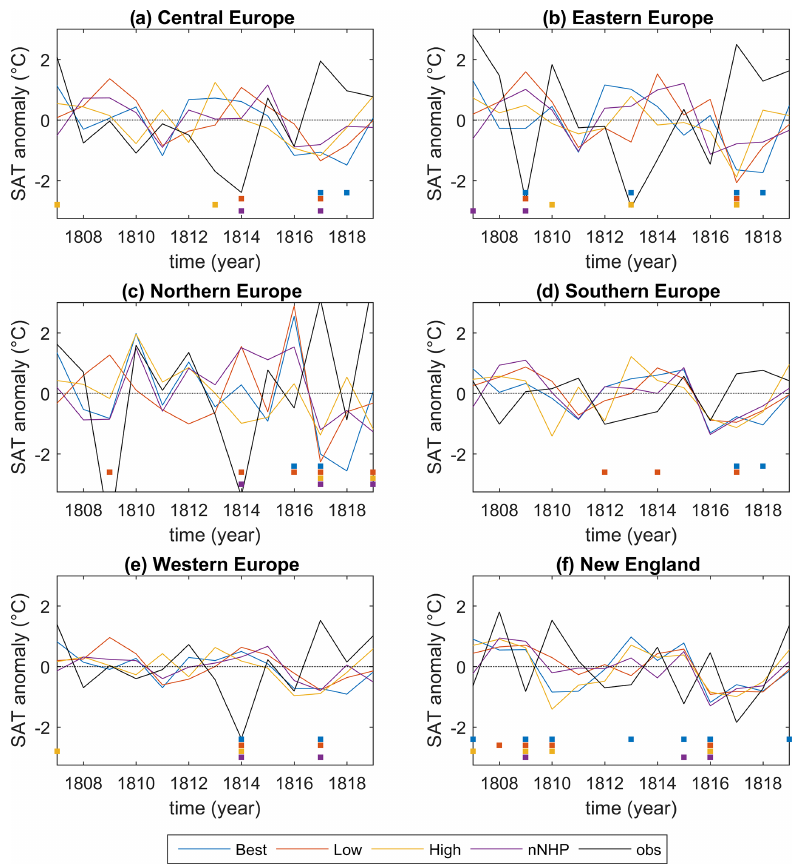
Figure 13. Same as Fig. 12 but for seasonal mean near-surface NH winter temperature anomalies ( ◦ C). The year corresponds to the month of